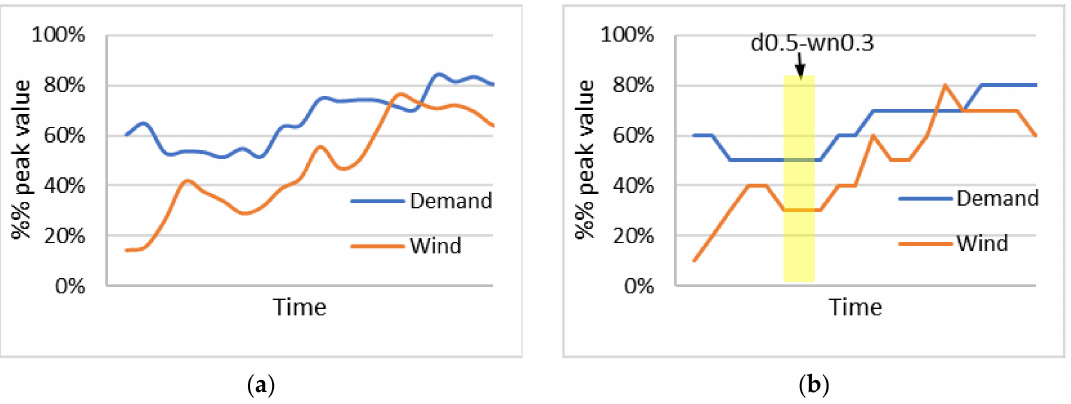
Figure 1. ( a ) Normalised hourly demand and wind power time series and ( b ) discretised wind and demand time series. ‘d0.5-wn0.3’ is the period with demand at 50% of peak and wind at 30% of